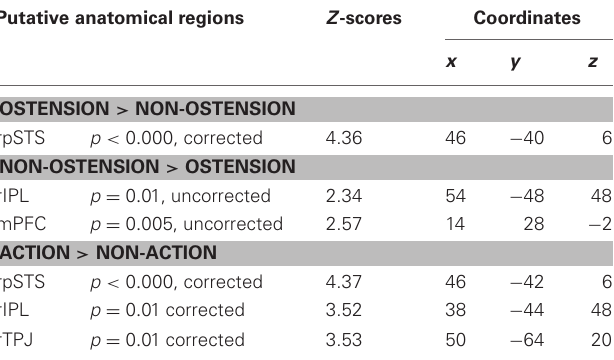
Table 2 | Eye-movement corrected fMRI results (11